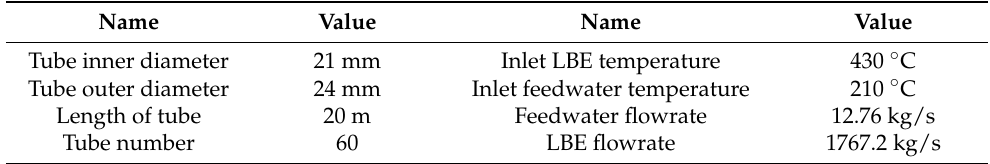
Table 2. The OTSG parameters.